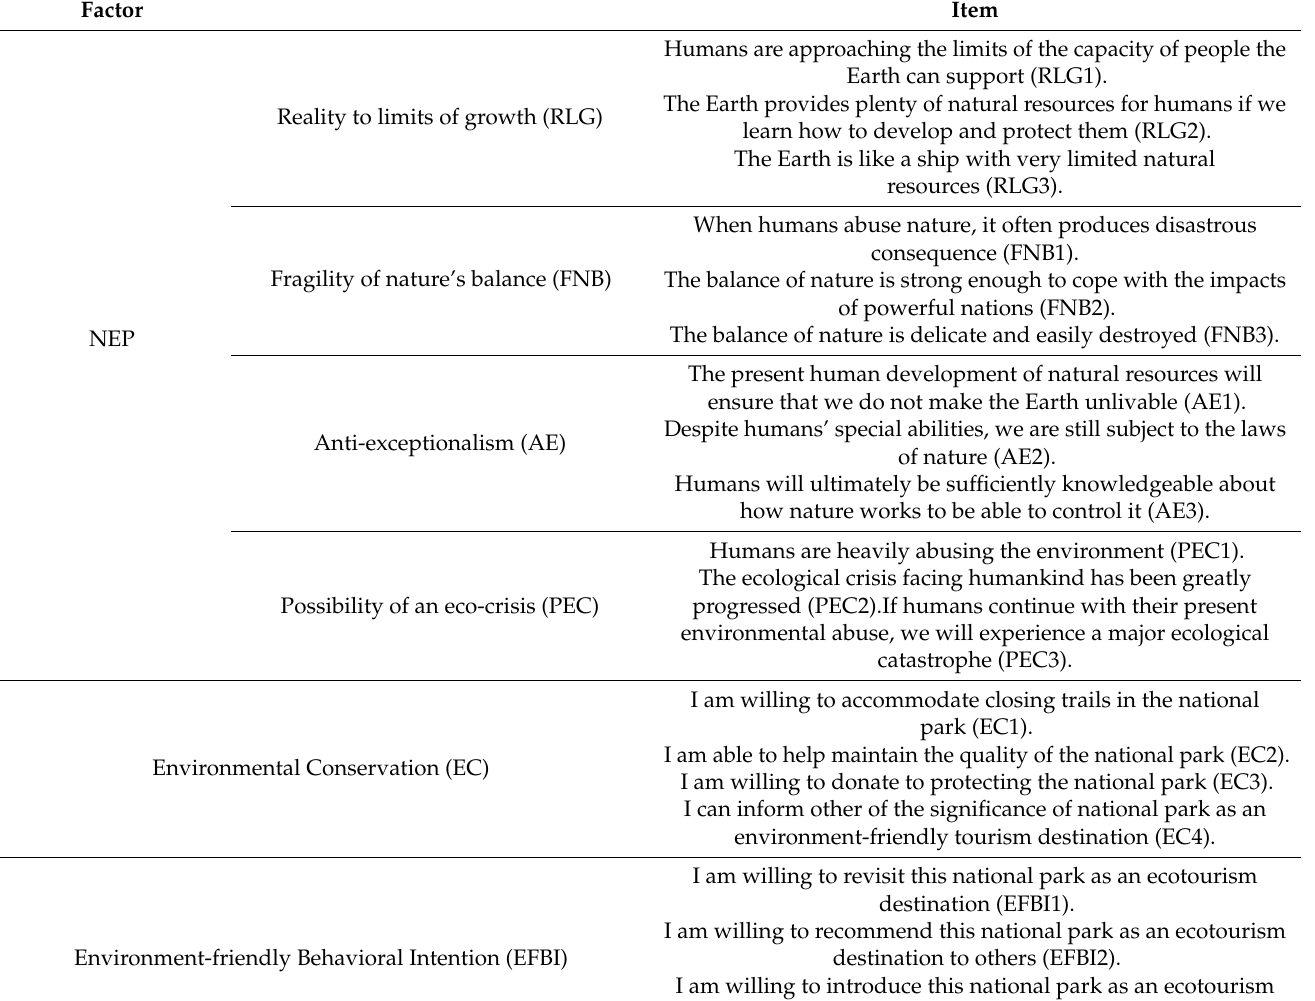
Table 1. Measures of the NEP, environmental conservation and environment-friendly behavior intention. Factor Item